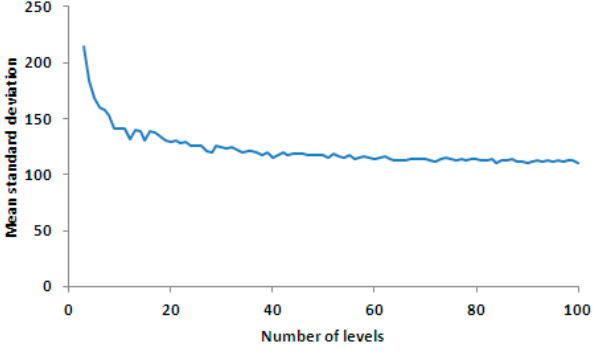
Figure 13. Mean value curve of the standard deviation of the corrected results for each line for various numbers of radiance level. The horizontal axis is the number of levels, and the vertical axis is the precision of correction result (mean standard deviation).